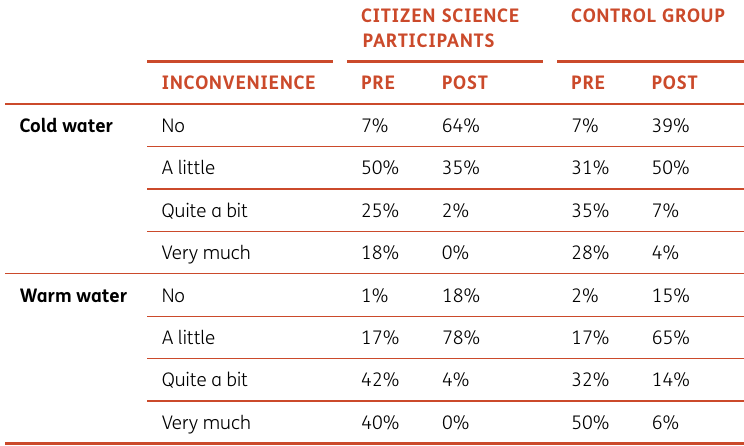
Table 4 Experienced inconvenience due to calcium precipitation.